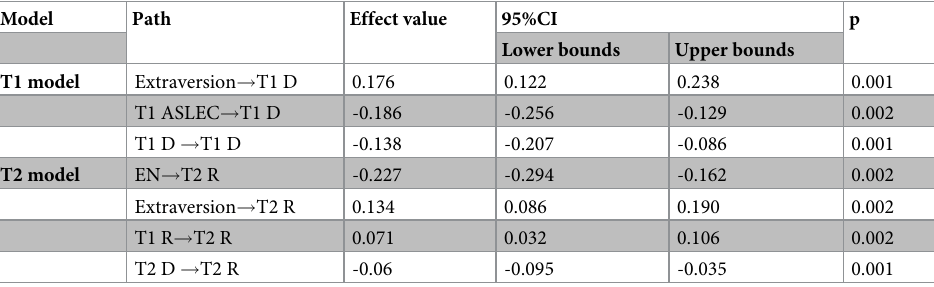
Table 5. Indirect effects and bootstrap analysis of